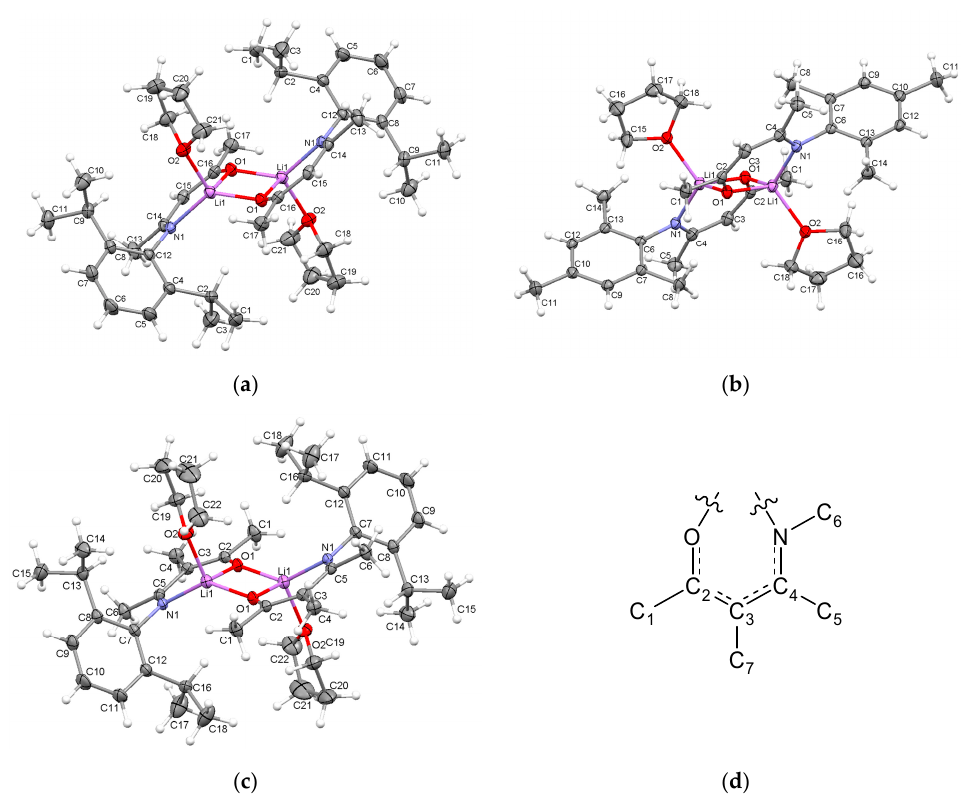
Figure 2. Displacement ellipsoids plots (40% probability) of the centrosymmetrically dimerized molecular structures of transoid Li 2 O 2 square clusters as found in their crystal structures: ( a ) THF-solvated cluster 2a ; ( b ) THF-solvated cluster 2b ; and ( c ) one of two independent THF-solvated clusters of 2c ; ( d ) The atom numbering scheme is the same used in Tables 1–3 for geometrical comparisons.